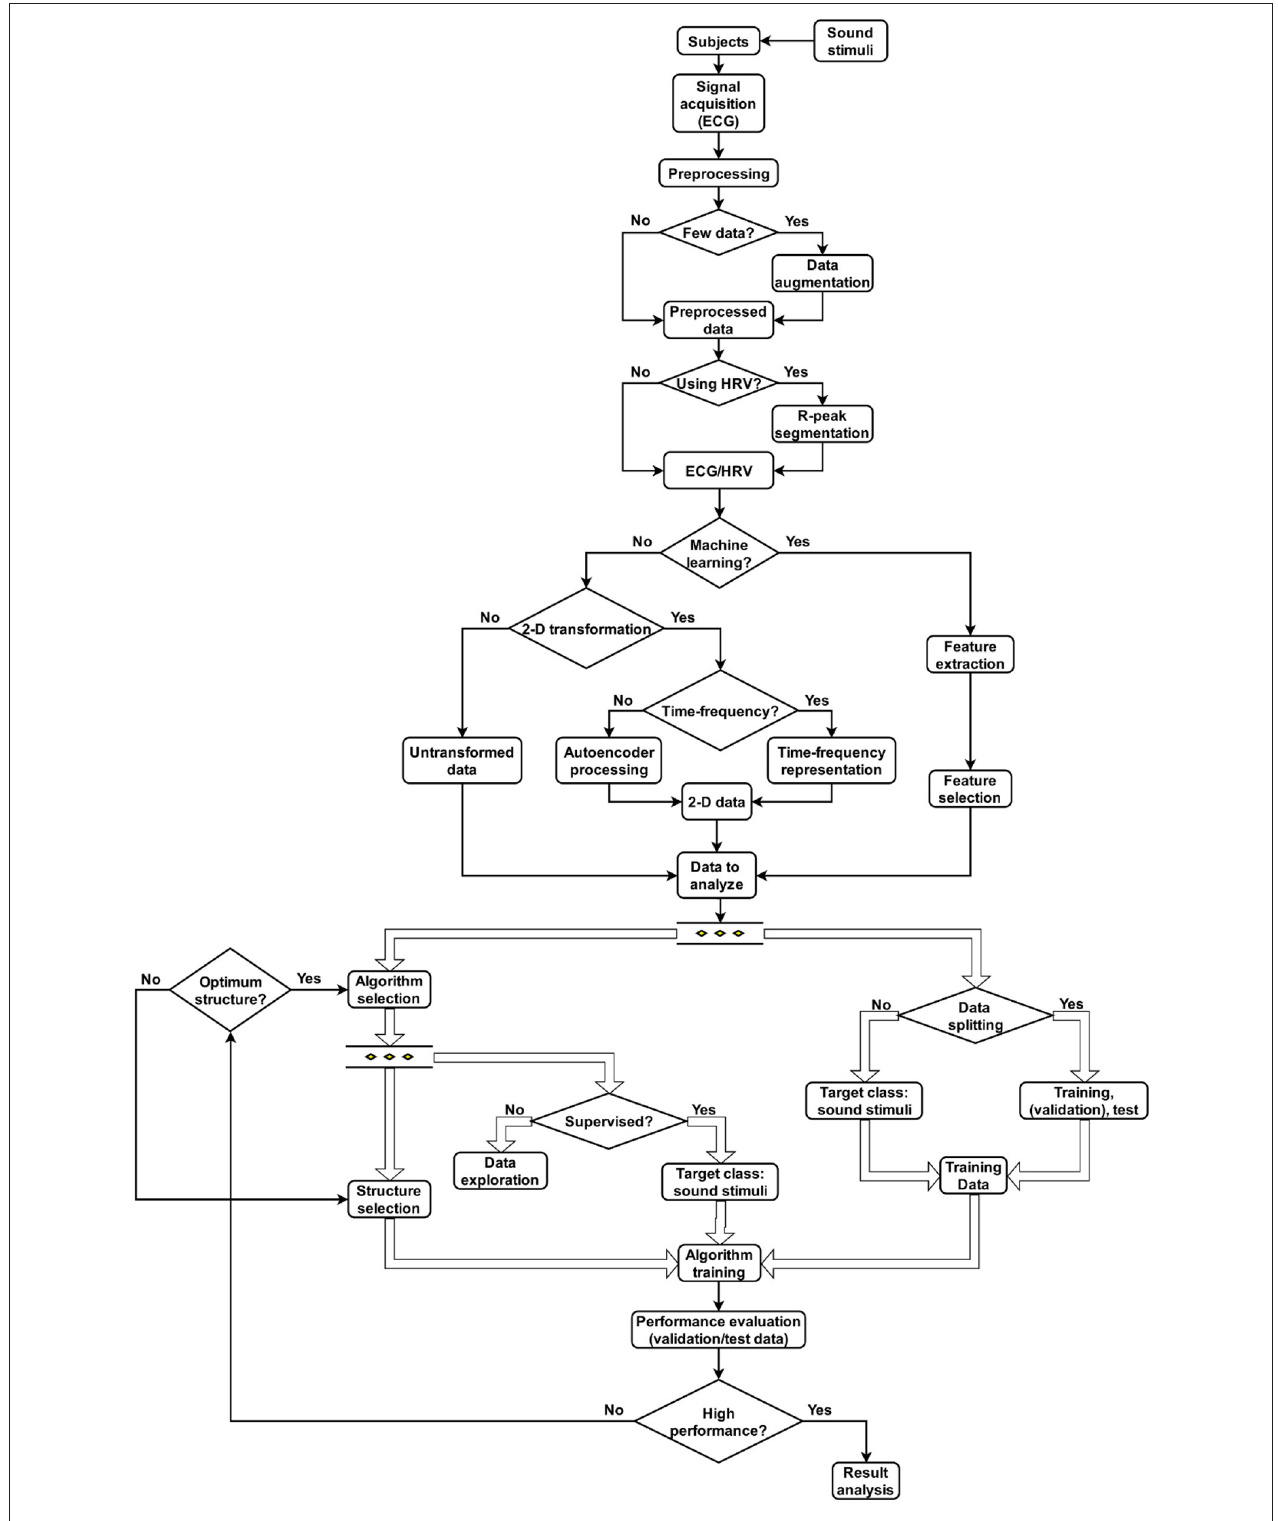
FIGURE 5 | Methodology for the association between sound stimuli and ECG/HRV signals.